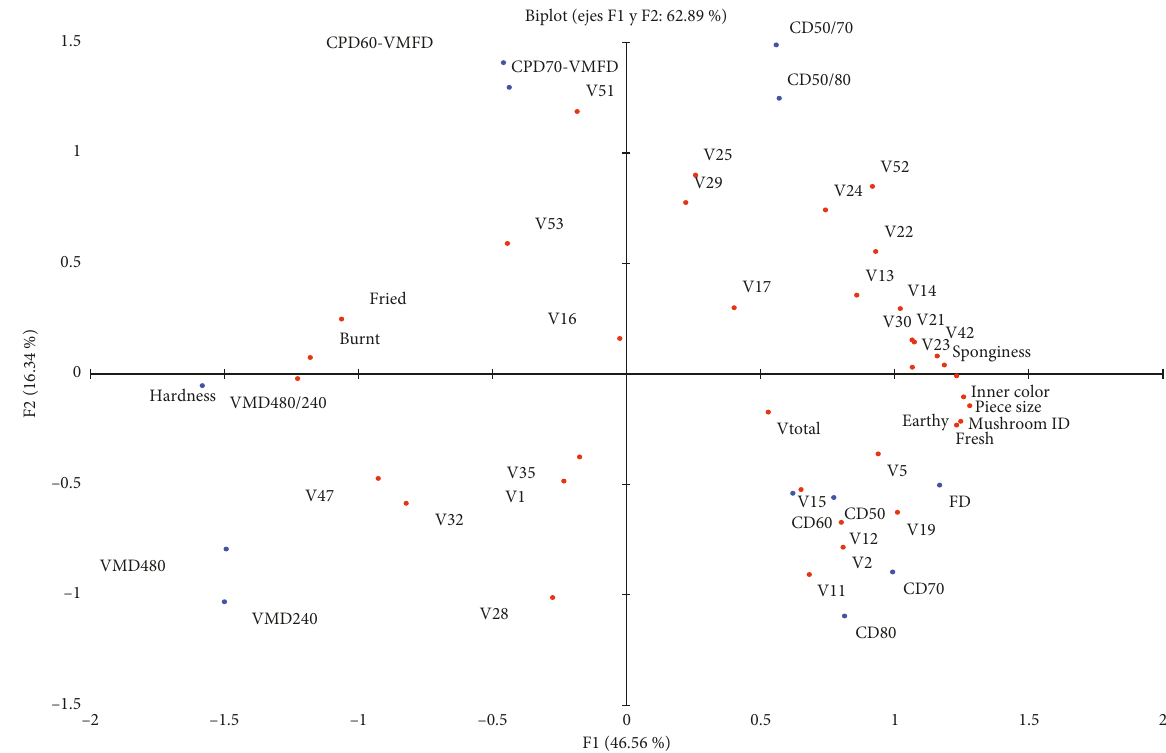
Figure 3: PCA score plots showing relationships among volatile compounds, sensory attributes, and dried Boletus edulis samples dehydrated by different